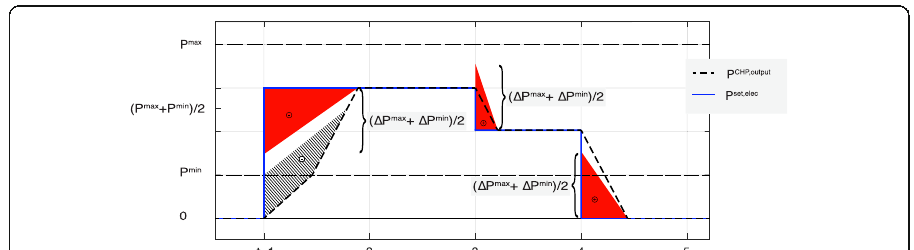
Fig. 1 Power gradient energy correction. The figure shows the set values P set , elec for an exemplary run of a CHP unit. The graph P CHP , output displays the reaction of the CHP unit to the given set values, under the